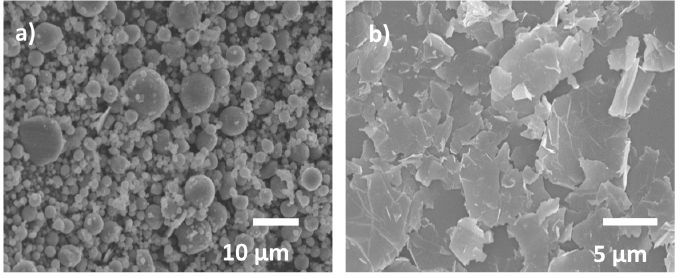
Figure 2. SEM micrograph showing ( a ) starting spherical Aluminum powder and ( b ) Graphene nanoplatelets (GNPs).